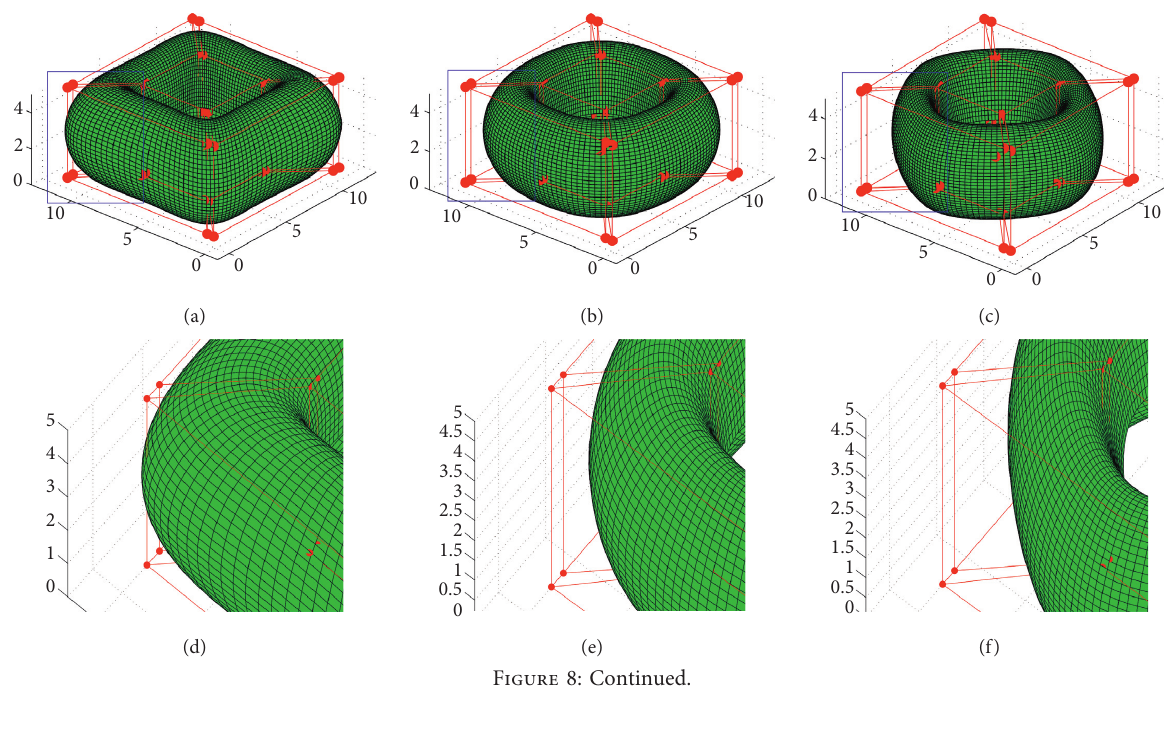
Figure 7: (a–c, g–i) The surfaces generated by the tensor product of scheme S rectangles of (a–c), respectively. (j–l) The 2-dimensional images in xy -planes of (g–i),